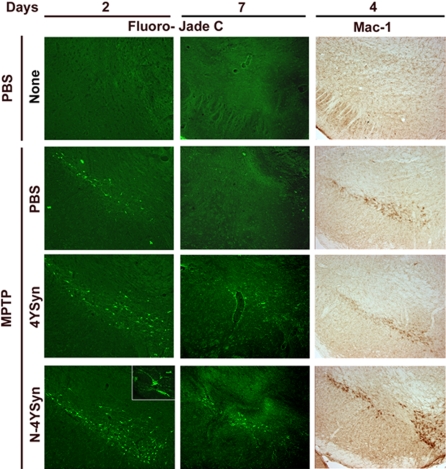
SPC from N-4YSyn immunized B10.BR mice exacerbate MPTP-induced dopaminergic neurodegeneration and induce microglial responses in the SNpc.Photomicrographs from VMB sections stained with Fluoro-Jade C (left and middle panels) and Mac-1 antibody (right panels). PBS controls (PBS/none) exhibit an absence of Fluoro-Jade C stained dead neurons on days 2 and 7, and only faint Mac-1 immunoreactivity on day 4 post-treatment. In MPTP-treated mice that received SPC from PBS/adjuvant treated donors (MPTP/PBS), Fluoro-Jade C stained neurons are evident at day 2, but not detectable by day 7. MPTP-treated mice that received SPC from 4YSyn immunized donors (MPTP/4YSyn), also exhibits dead fluorescent neurons by day 2 comparable to the MPTP/PBS control group, and only rare degenerating neurons are visible by day 7. Mac-1 immunoreactivity in those mice is comparably resolved to levels seen in MPTP/PBS control group. SPC transfers from N-4YSyn immunized donors to MPTP-treated mice (MPTP/N-4YSyn) induced a robust and prolonged microglial response, conspicuously enhanced when compared to MPTP/PBS-treated controls, with concomitant neuronal death still evident by Fluoro-Jade C staining at day 7.